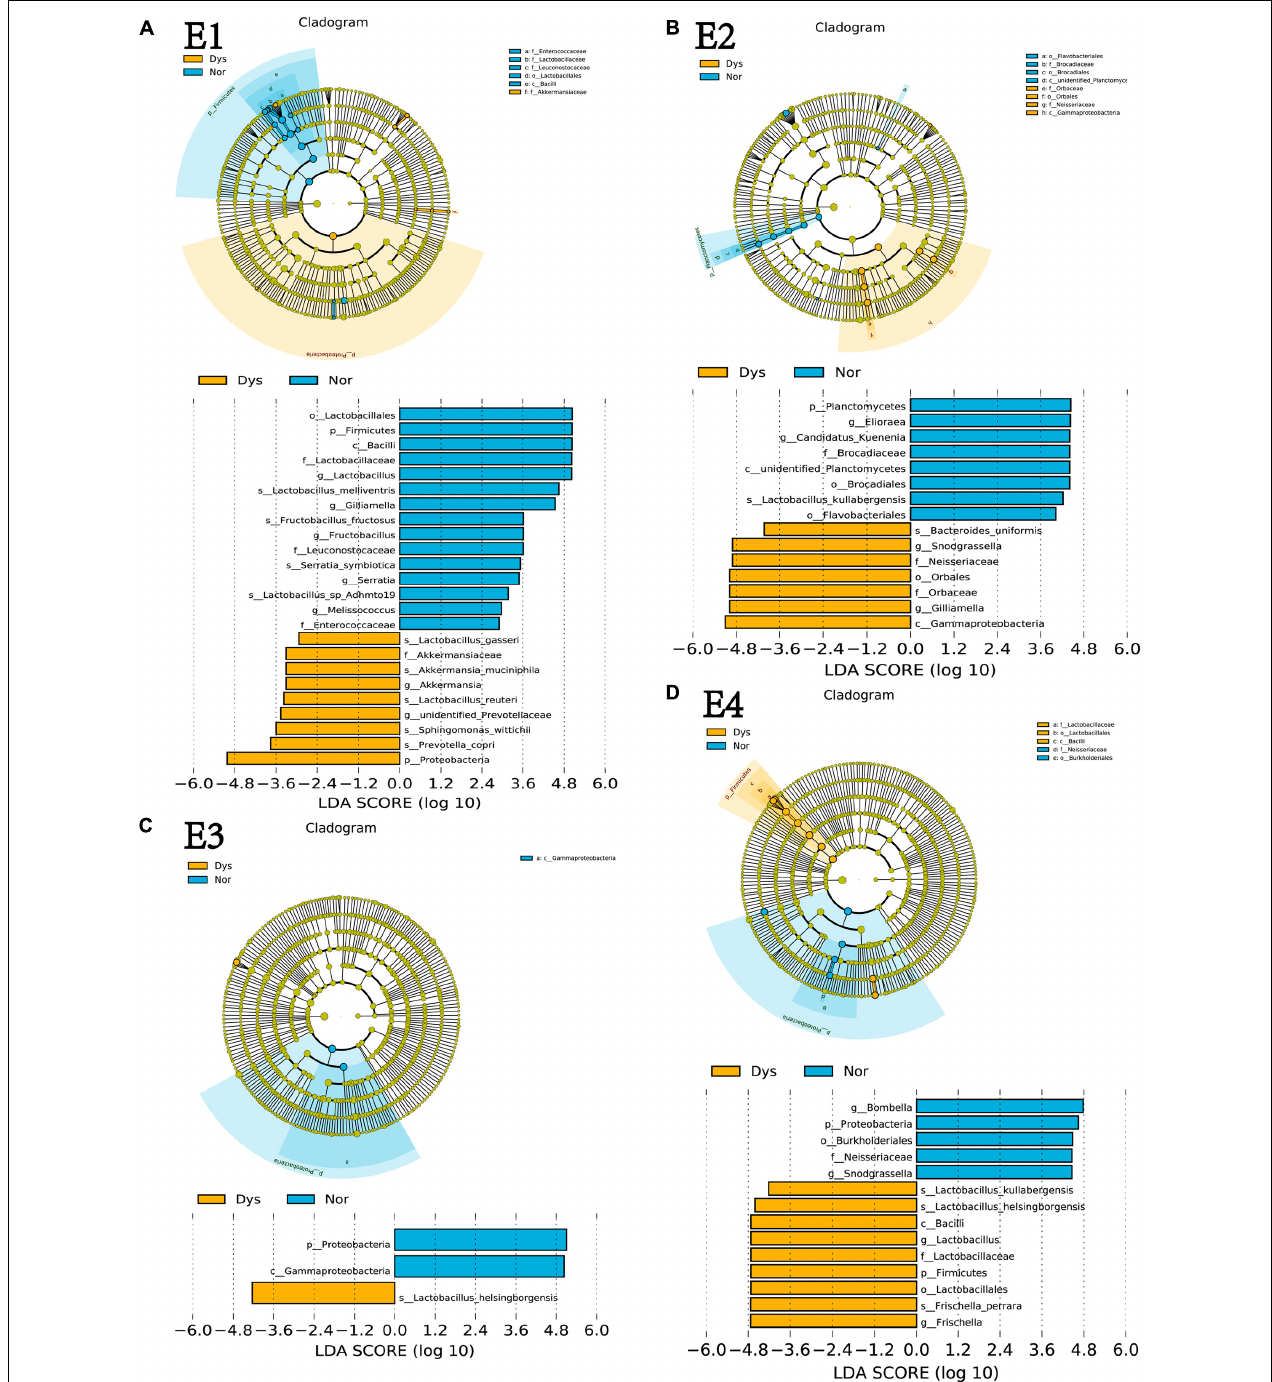
FIGURE 5 | The main taxa that were different in Nor vs Dys in E1 (A) , E2 (B) , E3 (C) and E3 (D) on the basis of LEFSe analysis (taxa with > 4). Blue represents taxa that significantly higher in Nor bees and yellow represents taxa that significantly higher in Dys bees. E1–E4 represent four experimental replicates with different colony. Nor: workers colonized with normal gut community, Dys, workers colonized with dysbiotic gut community.